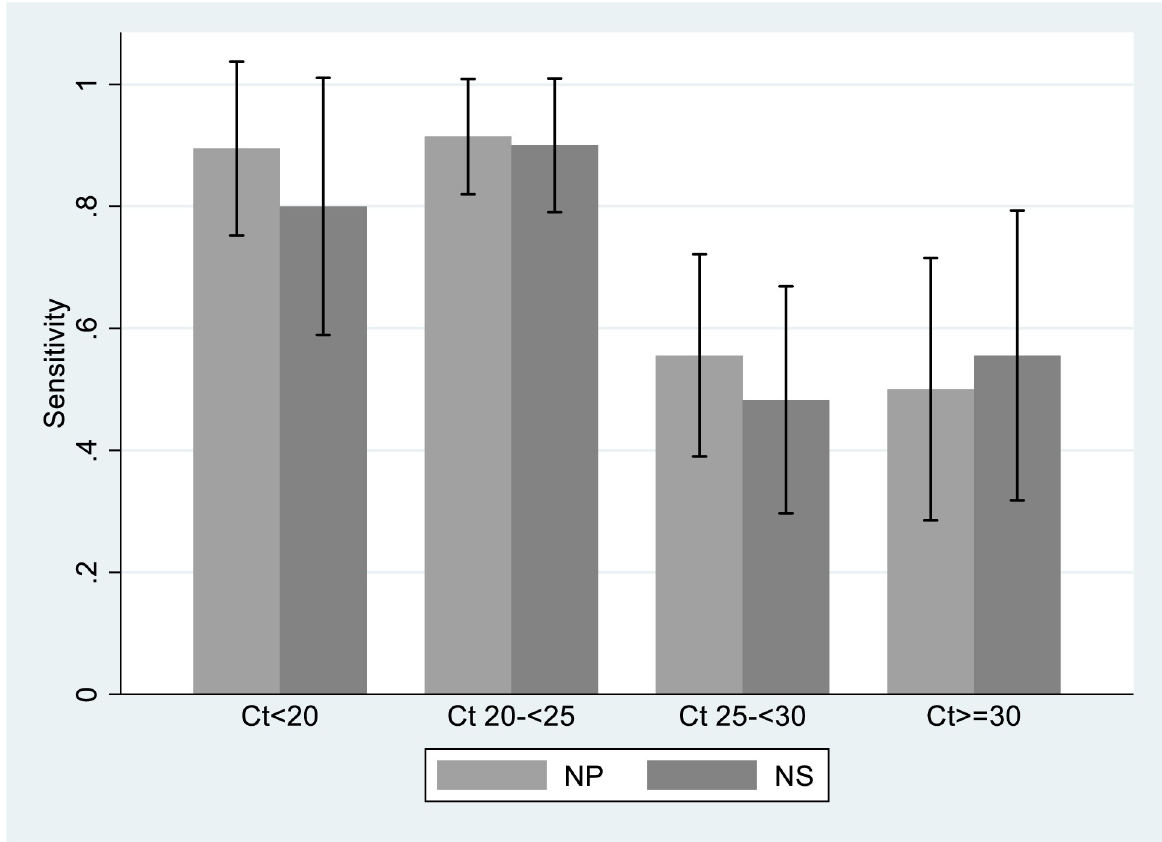
Fig 3. Sensitivity of nasal Ag-RDT (NS) and nasopharyngeal Ag-RDT (NP) according to PCR Ct value. The graph includes in total 92 out of the 124 participants with positive PCR. 12 had a positive PCR from Xpert (no Ct value reported), 20 had nasal, nasopharyngeal or both Ag-RDTs missing.